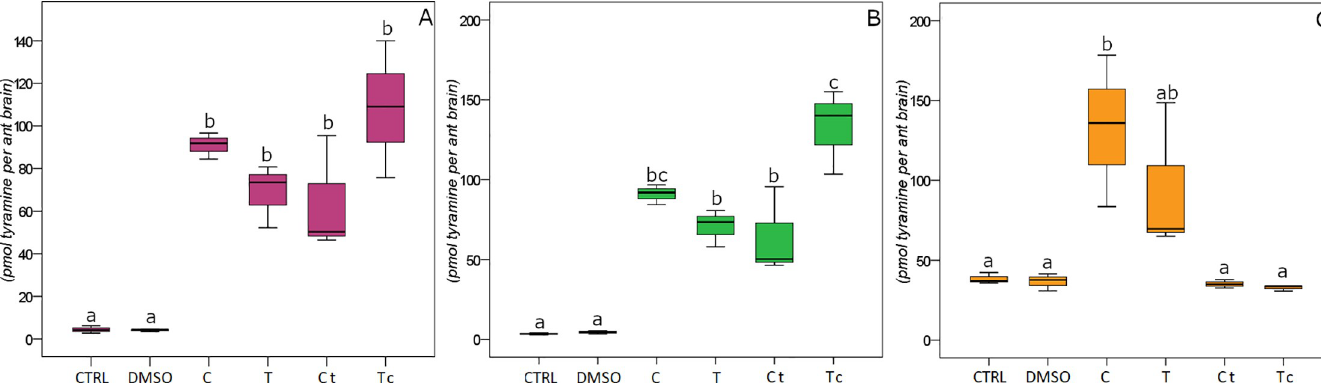
Fig 3. Tyramine content. Effects of treatments (C: carvacrol; T: thymol; Ct: 3:1 (v/v) carvacrol/thymol; Tc: 1:3 (v/v) carvacrol/thymol) and controls (CTRL and DMSO) on tyramine contents in ant brains of Formica cinerea (A), Tetramorium caespitum (B) and Myrmica scabrinodis (C). Values are expressed as pmol tyramine per ant brain. Boxplots show median, quartile, maximum and minimum values; different letters indicate significant differences (Tukey’s HSD post hoc, p < 0.05; S3 Table). https://doi.org/10.1371/journal.pone.0209047.g003 PLOS ONE | https://doi.org/10.1371/journal.pone.0209047 December26,